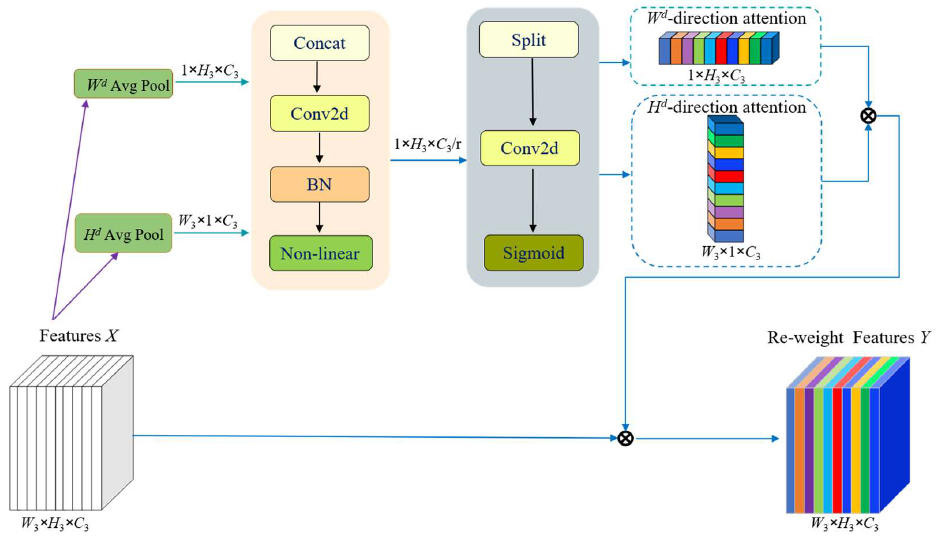
Figure 3. The architecture of coordinate attention. For the input feature tensor